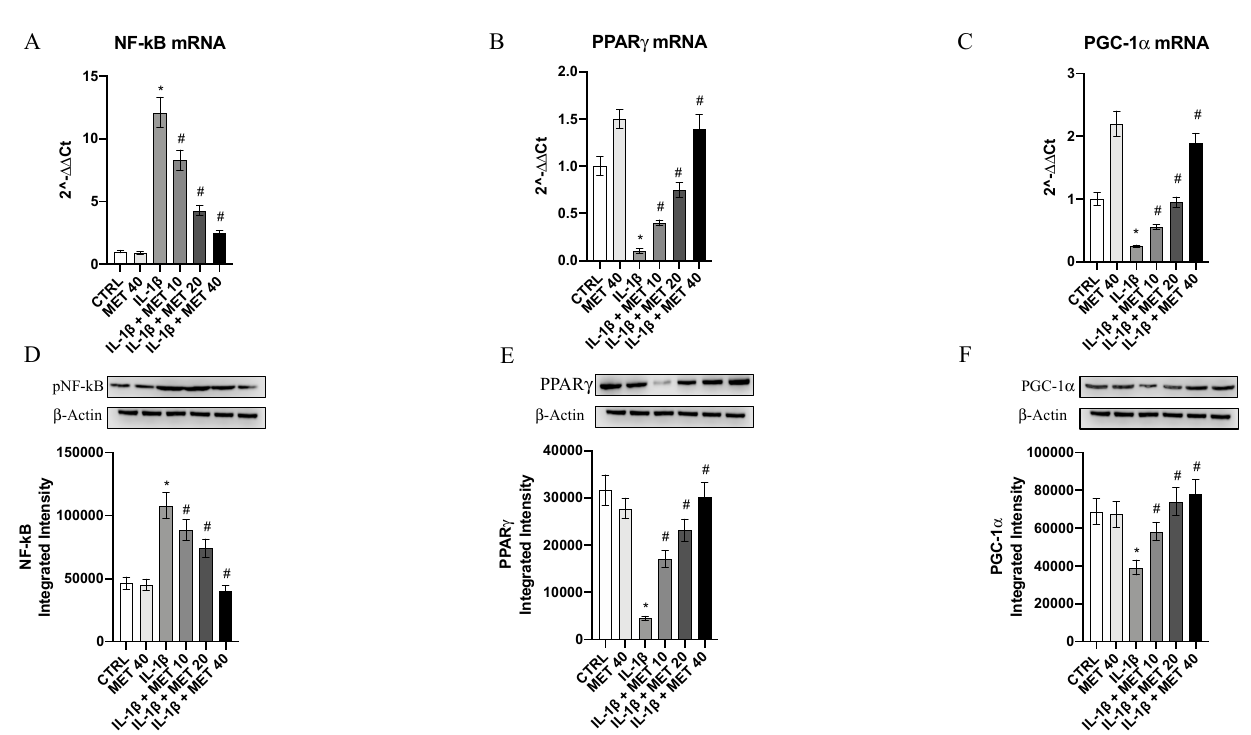
Figure 3. Effects of metaxalone on NF-kB ( A ), PPAR γ ( B ), and PGC-1 α ( C ) mRNA expression. Effects of metaxalone on pNF-kB ( D ), PPAR γ ( E ), and PGC-1 α ( F ) protein levels. Values are expressed as the means ± SD. *, p < 0.0001 vs. CTRL; #, p < 0.0001 vs. IL-1 β .